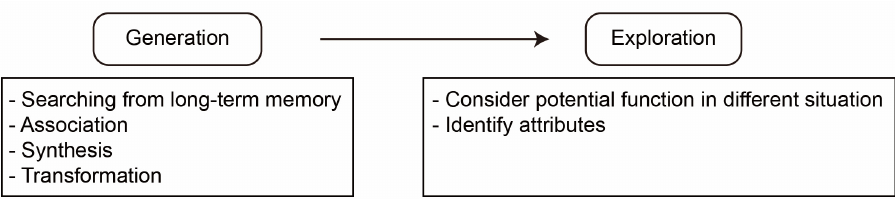
Figure 3. The Genoplore model.